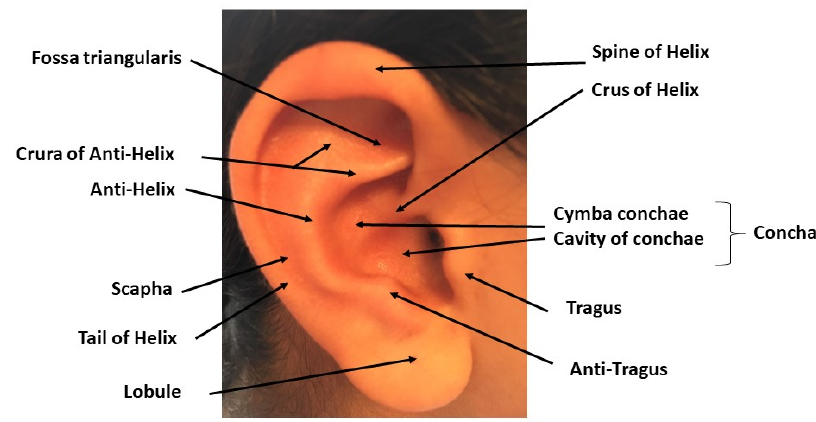
Figure 1. Gross anatomy of the Auricule: the main components of the outer ear are named and pointed on the picture. Copyright Dr. Rangon.